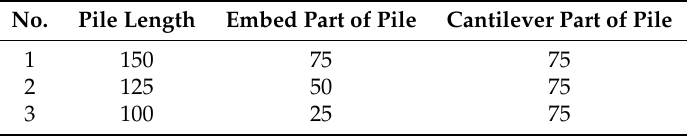
Table 1. Geometrical sizes of the pile in the model (Unit: mm).